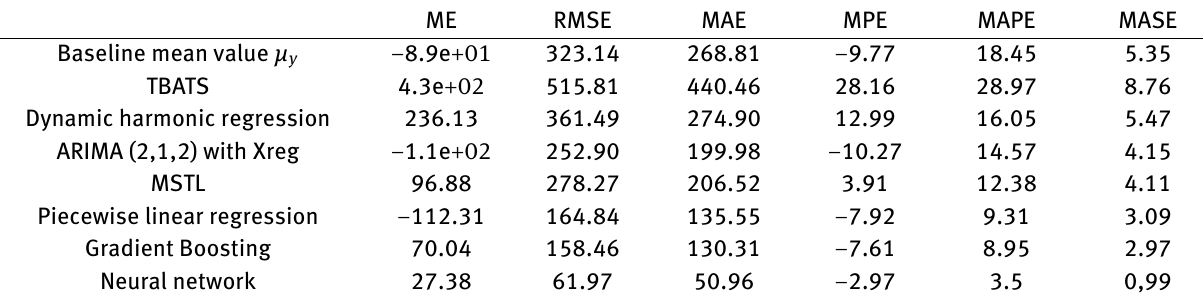
Table 2: Forecast accuracy for test data sets ME RMSE MAE MPE MAPE MASE